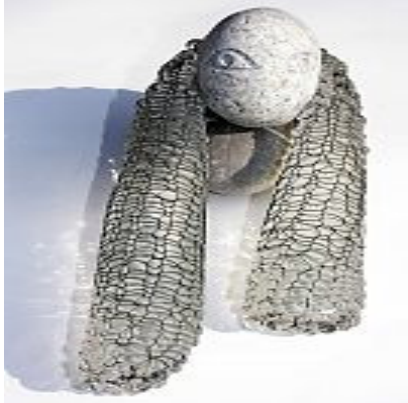
Figure 7. Uta Majmudar; Streckt die Arme , 2007, glass and metal wire, hot fused. Courtesy of the artist, used with permission.